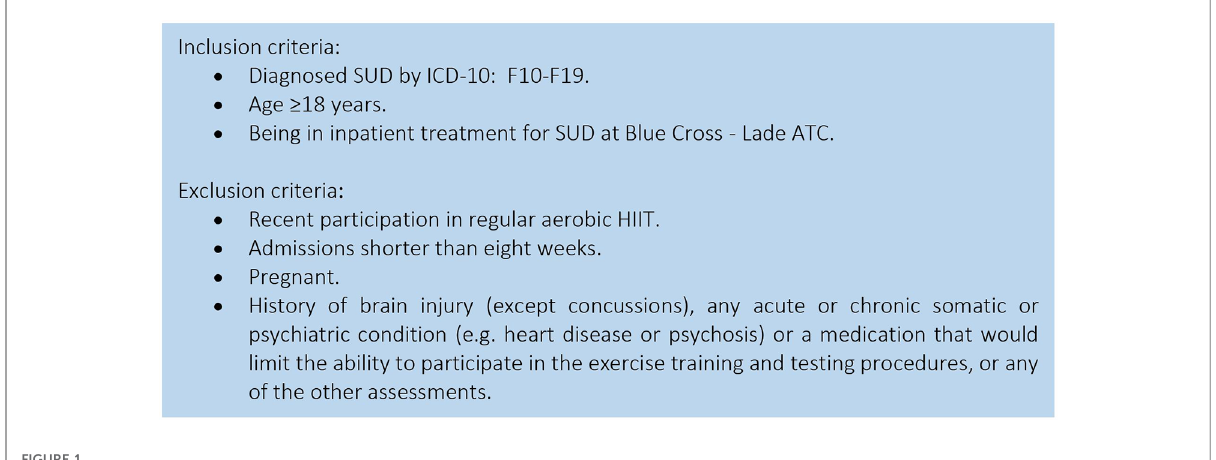
FIGURE 1 Inclusion and exclusion criteria for participants. SUD, Substance use disorder; ICD-10: F10-19=International Classi fi cation of Diseases-10: F10-F19: Mental and behavioral disorders due to psychoactive substance use; ATC, Addiction treatment center; HIIT, High-intensity interval training.